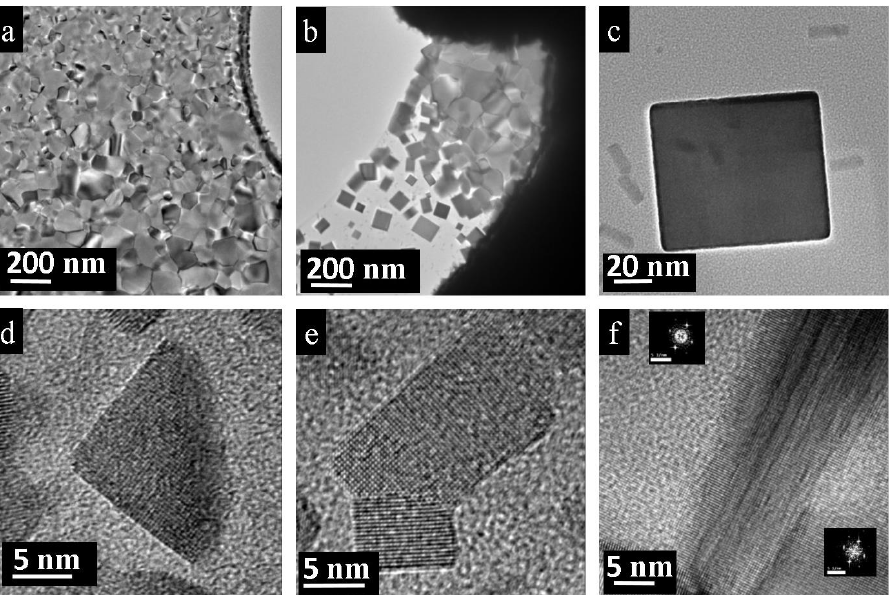
Figure 7. Electron-beam treatment of polycrystalline PbTe annealed at 400 °C: ( a ) Overview of a layer. ( b ) Formation of the large nano-bars next to the source particle. ( c ) Individual, very large nano-bar. ( d ) Partially formed nano-bar. ( e ) Imperfect attachment of nanoparticles with a screw dislocation. ( f ) Edge dislocation on the border between two grains both oriented in the [100] direction. However, the formed layer was not perfect and contained holes and grain bounda-